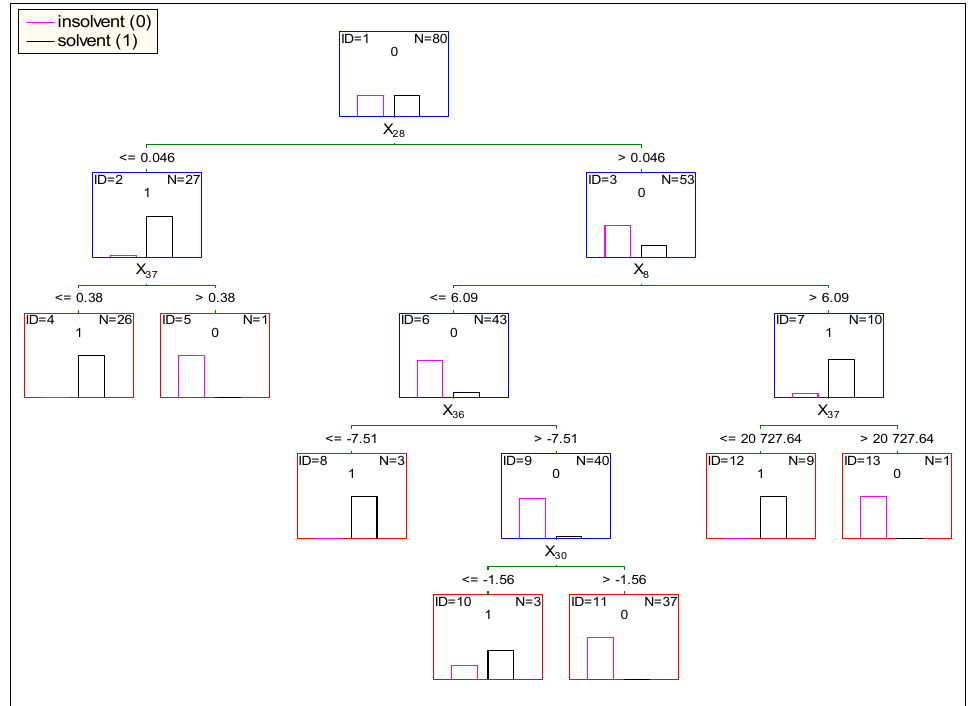
Figure 1. Classification regression tree for insolvency prediction for construction companies (ZRT).